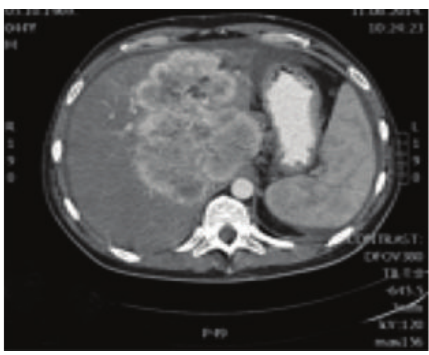
Figure 6: In arterial phase liver lesion was better visualized. Central parts of the lesion after the contrast has been administered remained hypodense, while margins of the lesion were intensively